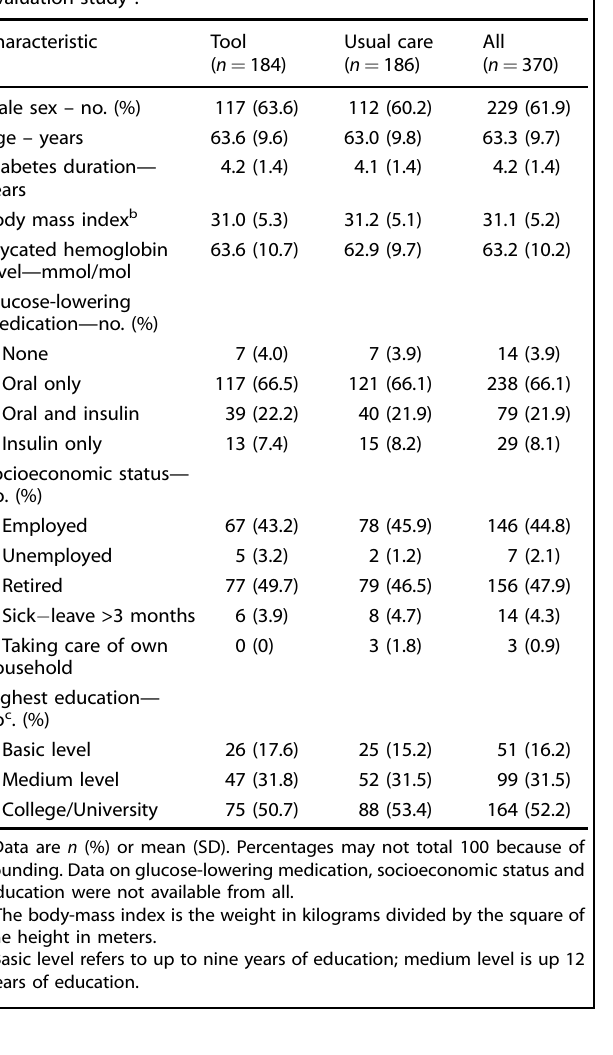
Table 1. Demographic and baseline characteristics of participants in